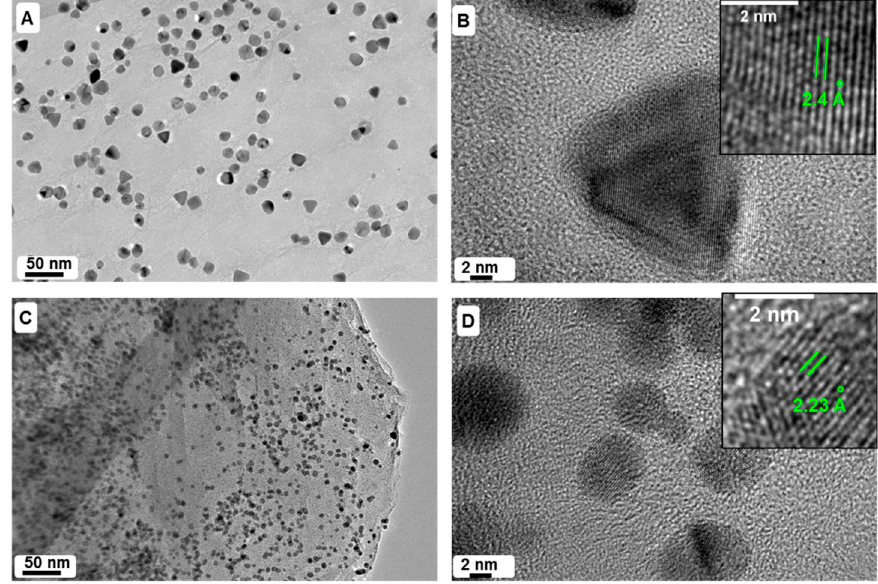
Figure 1. Transmission electron microscope (TEM) and high ‐ resolution (HRTEM) images of the Pd@graphene nanocatalyst (PG ‐ HRG ‐ Pd ‐ 1) ( A ) overview PG ‐ HRG ‐ Pd (50 wt % ratio of Pd precursor); ( B ) HRTEM image confirming the triangular shape of Pd nanoparticles with distance between two Pd lattice fringes is 2.4 Å (inset) corresponding to (111) crystal planes of face ‐ centered cubic ( fcc ) Pd crystals; ( C ) overview PG ‐ HRG ‐ Pd (75 wt % ratio of Pd precursor) showing the enhanced density of Pd nanoparticles and ( D ) high ‐ resolution (HRTEM) image of the corresponding sample confirming the spherical morphology and also fcc structure of as synthesized Pd NPs (inset).